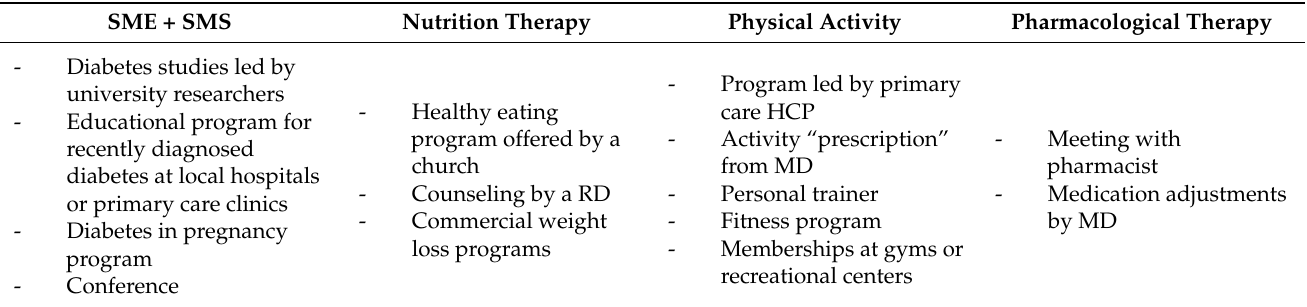
Table 2. Programs classified by their main pillar of T2D